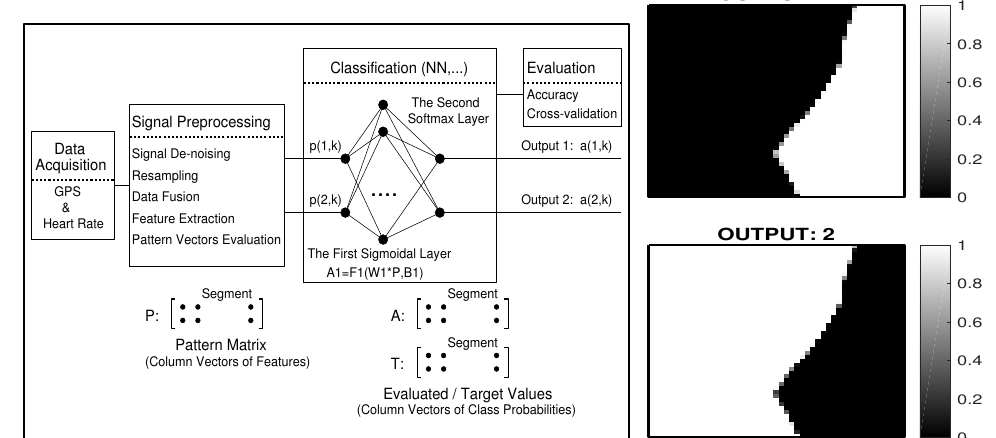
Figure 4. The diagram of multimodal cycling data processing and signal segments classification presenting outputs of the first and the second elements of the neural network (NN) output for classification into S 2 = 2